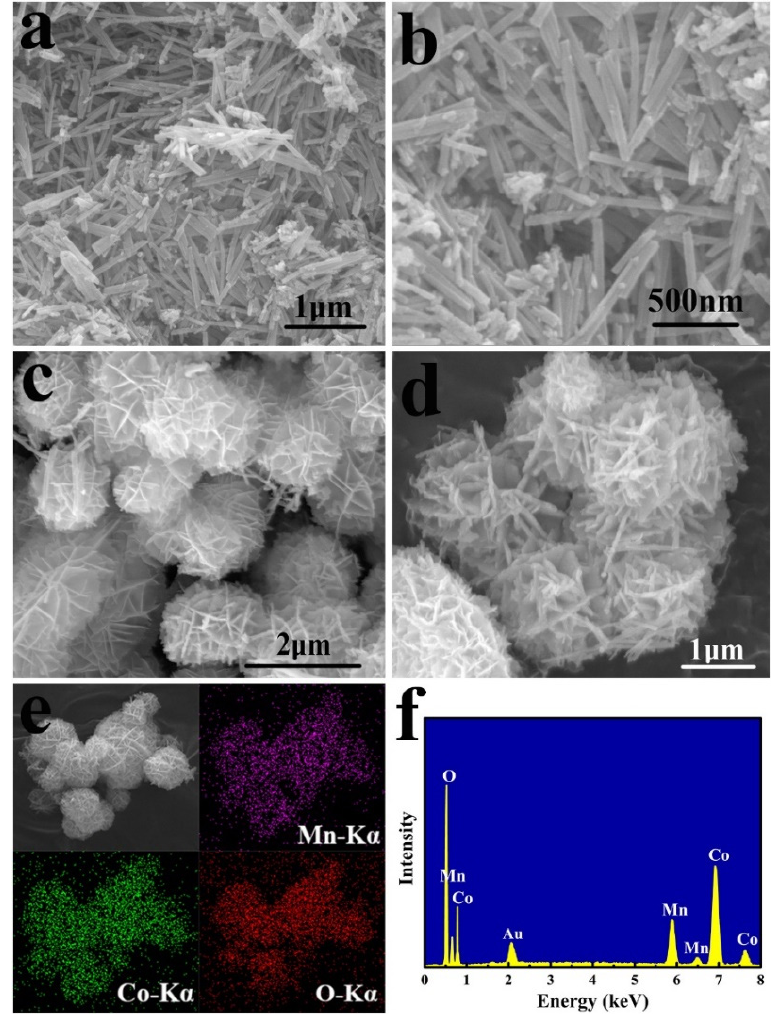
Figure 3. ( a , b ) The FE-SEM images of r-MCO; ( c , d ) The FE-SEM images of h-MCO; ( e ) The element mappings of h-MCO; ( f ) The EDS of h-MCO. Reproduced with permission from Xiaolan Song, Hydrothermal synthesis of porous hydrangea-like MnCo 2 O 4 as anode materials for high performance lithium-ion batteries; published by Elsevier, 2019 [58].